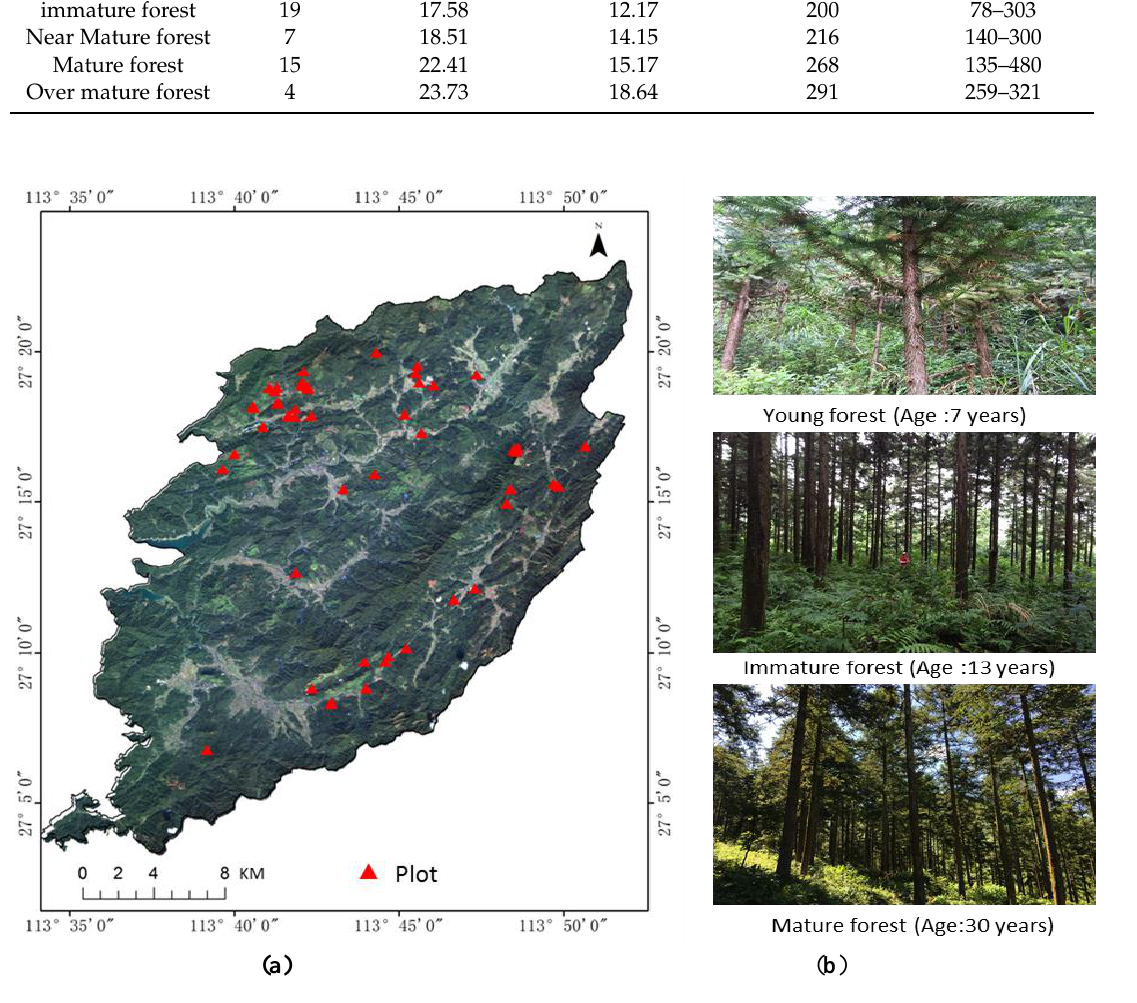
Figure 2. ( a ) Distribution of the selected plots; and ( b ) the photos of ground measured plots with different age